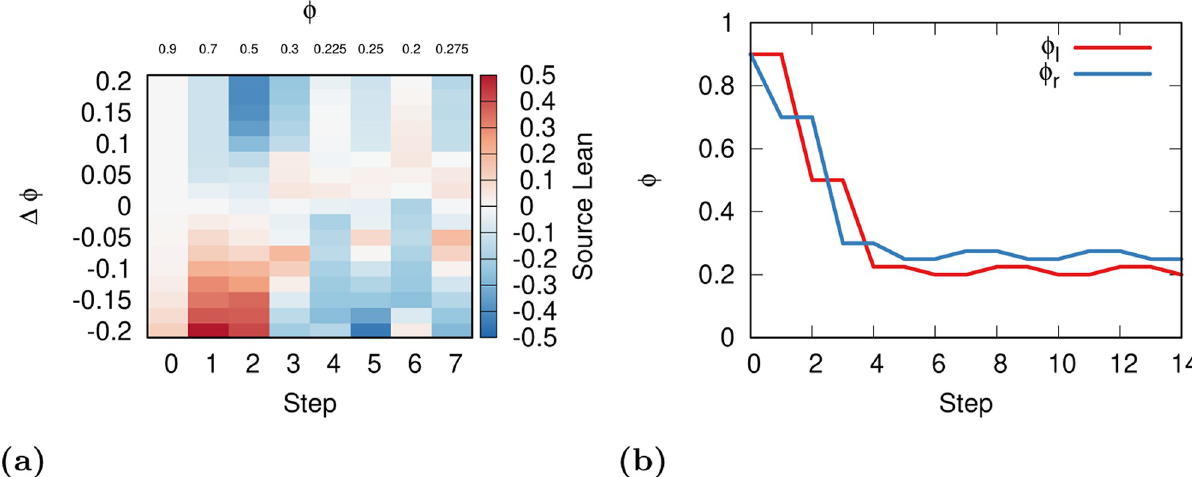
Fig 6. a. (a) For each step of the simulation (x axis) the amount of source polarity attraction (color) for a given change in tolerance with respect to the tolerance of the other side (y axis). Red indicates an attraction of the sources, blue a repulsion. Odd steps for changes in ϕ l , even steps for changes in ϕ r . Above each column we report the value of the opposite (fixed) ϕ for each step. (b) The evolution of ϕ (x axis).